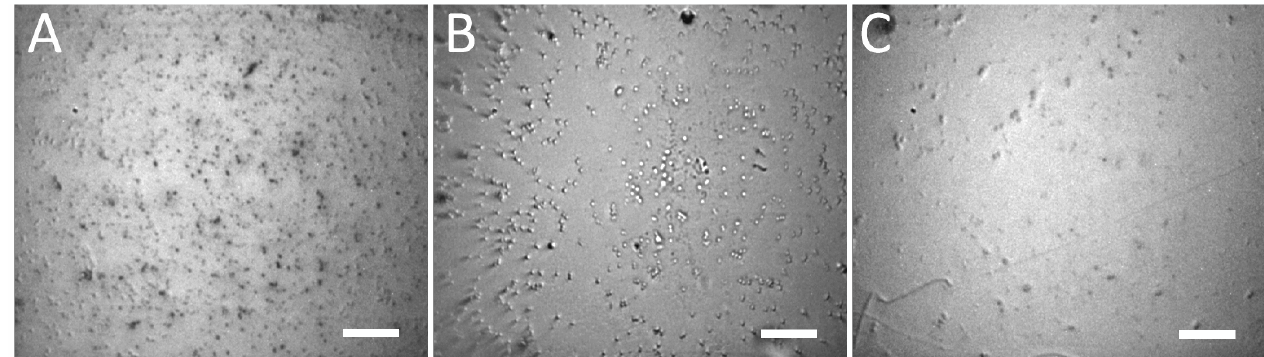
Figure 4. Bright-field microscope images of Au-coated glass derivatized with E. coli -specific antibody and treated with suspensions containing E. coli ; >1700 cells/FOV ( A ), S. aureus ; ≈ 400 cells/FOV ( B ) and S. marcescens ; ≈ 100 cells/FOV ( C ). The applied suspensions had equivalent bacterial concentrations in the order 1 × 10 5 CFU/mL. The Au ‐ coated glass was washed several times with PBS before observation, cf. Section 2.6. Microscope objective: 20×; scale bars: 20 μ m.